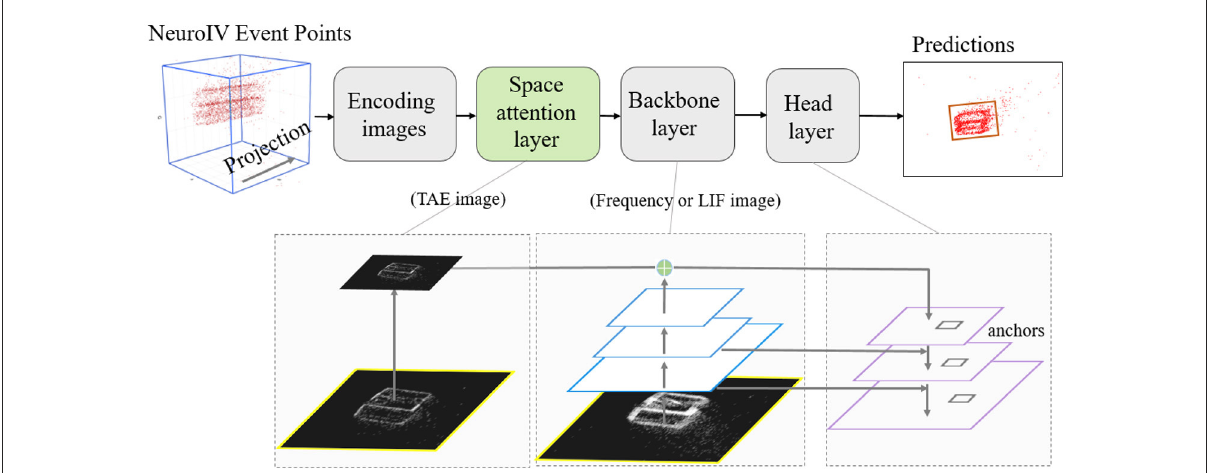
FIGURE3 NeuroVI-based YOLO detection model is fused with space attention. The TAE images are used to construct the space attention layer, which avoids the time delay and improves the box-position accuracy. The backbone layer extracts features from the frequency or LIF image.